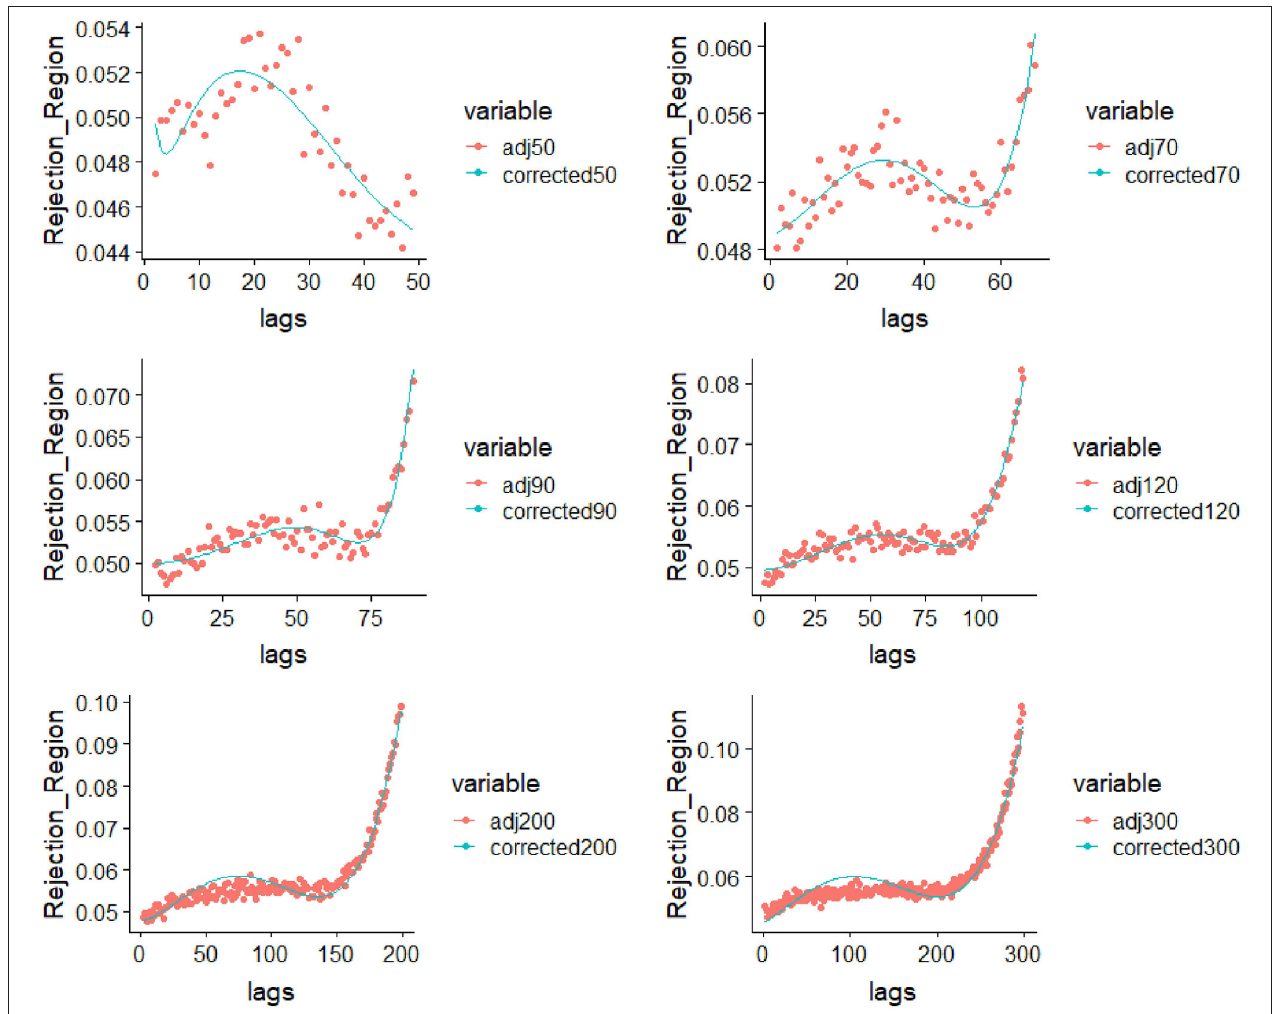
FIGURE 1 | Parametric correction to the rejection region for sample sizes 50, 70, 90, 130, 200, and 300.